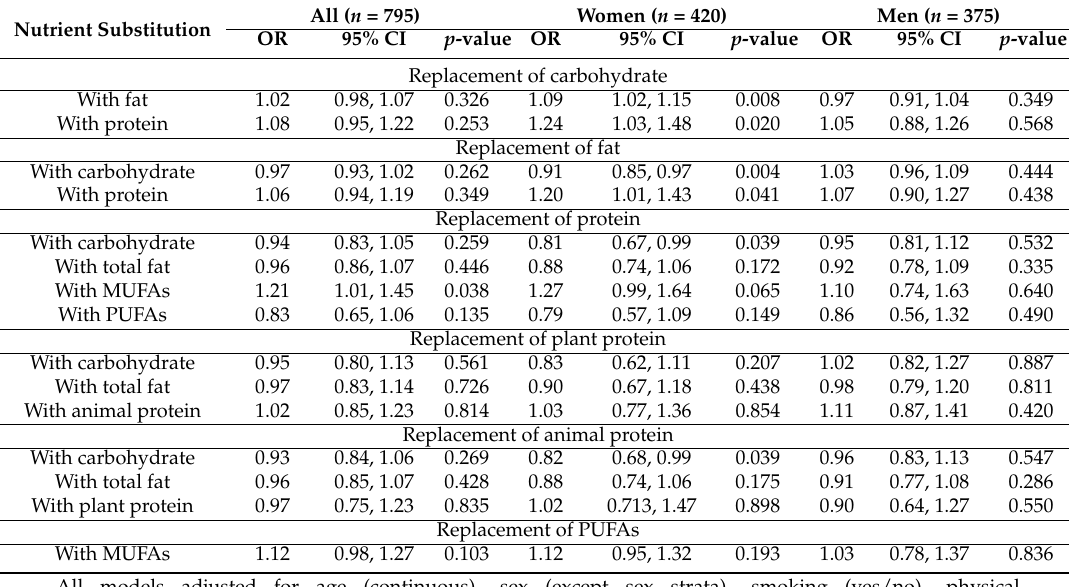
Table 4. Odds ratios (OR) of visceral adiposity dysfunction after 3 years according to the iso-energetic increase of 1% of energy from one macronutrient at the expense of